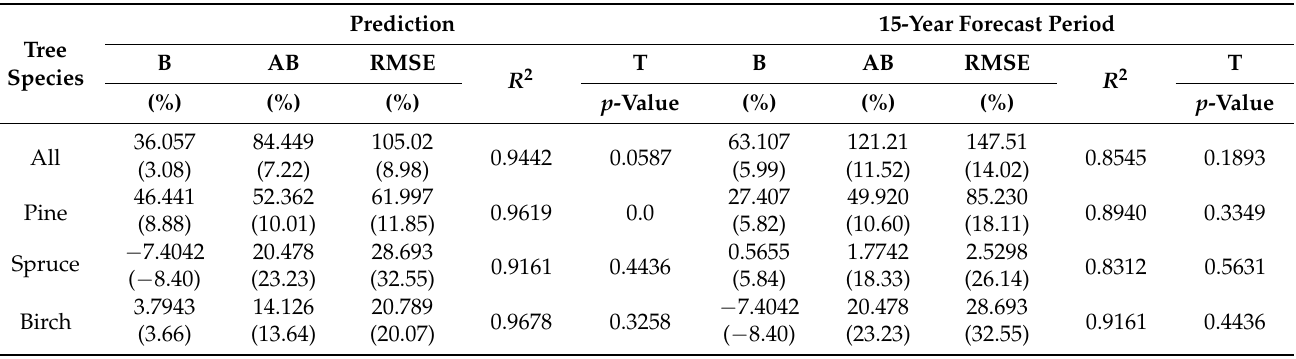
Figure 7. Kinetics of the stand density area for four randomly selected stands from a val- idation dataset: ( a ) all species; ( b ) pine ( Pinus sylvestris ), k pine = 0.73, 0.18, 0.31, 0.93 ( black, red, blue, and green ), respectively; ( c ) spruce ( Picea abies) k spruce = 0.05, 0.23, 0.80, 0.61 ( black, red, blue, and green ) , respectively; ( d ) silver birch ( Betula pendula Roth and Betula pubescens Ehrh.) k birch = 0.22, 0.02, 0.09, 0.07 ( black, red, blue, and green ) , respectively; black—first stand; red—second stand; blue—third stand; green—fourth stand; and circles—observed dataset. Table 12. Statistical measures and p -values of the Student’s t -test for the prediction and forecast of the stand